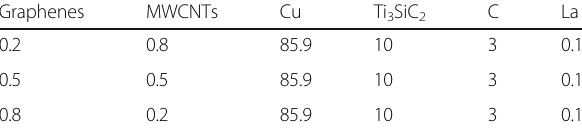
Table 2 Composition design details of the nanocomposites (wt%) Graphenes